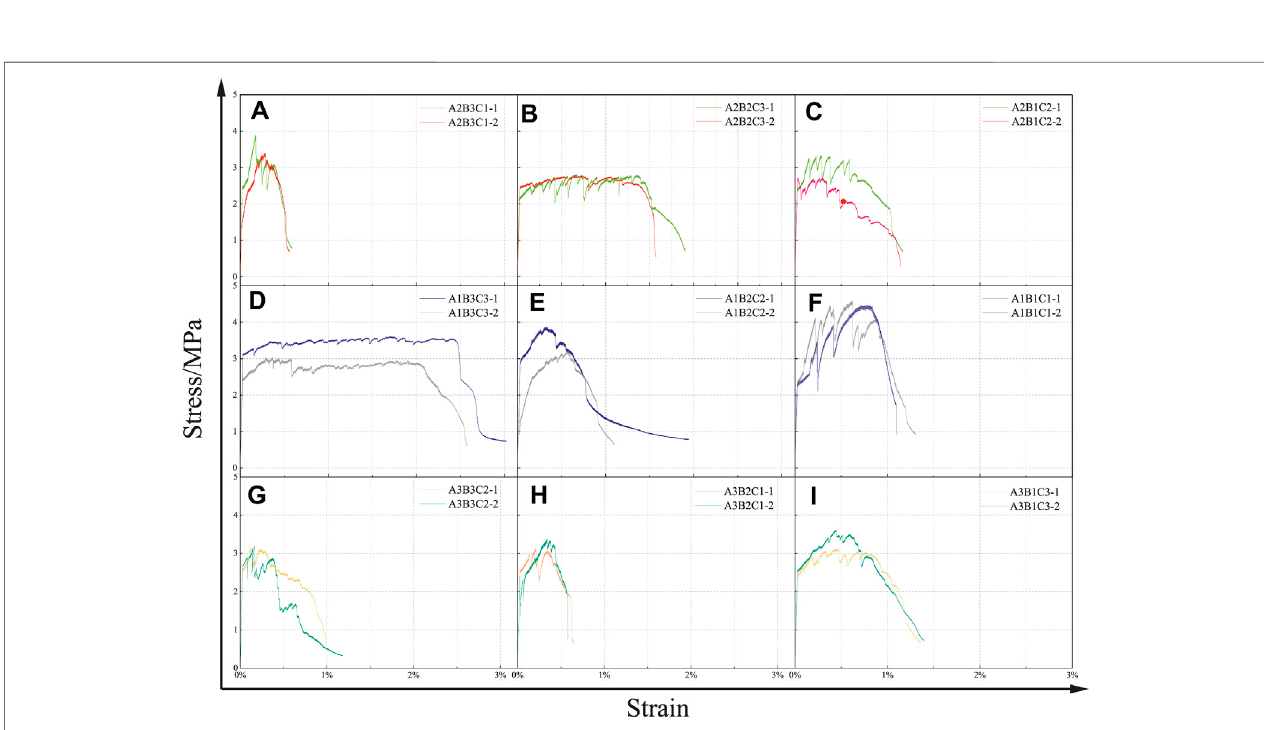
FIGURE 3 | Tensile stress – strain curves of SECCs. (A) : A2B3C1; (B) : A2B2C3; (C) : A2B1C2; (D) : A1B3C3; (E) : A1B2C2; (F) : A1B1C1; (G) : A3B3C2; (H) : A3B2C1; (I) : A3B1C3.